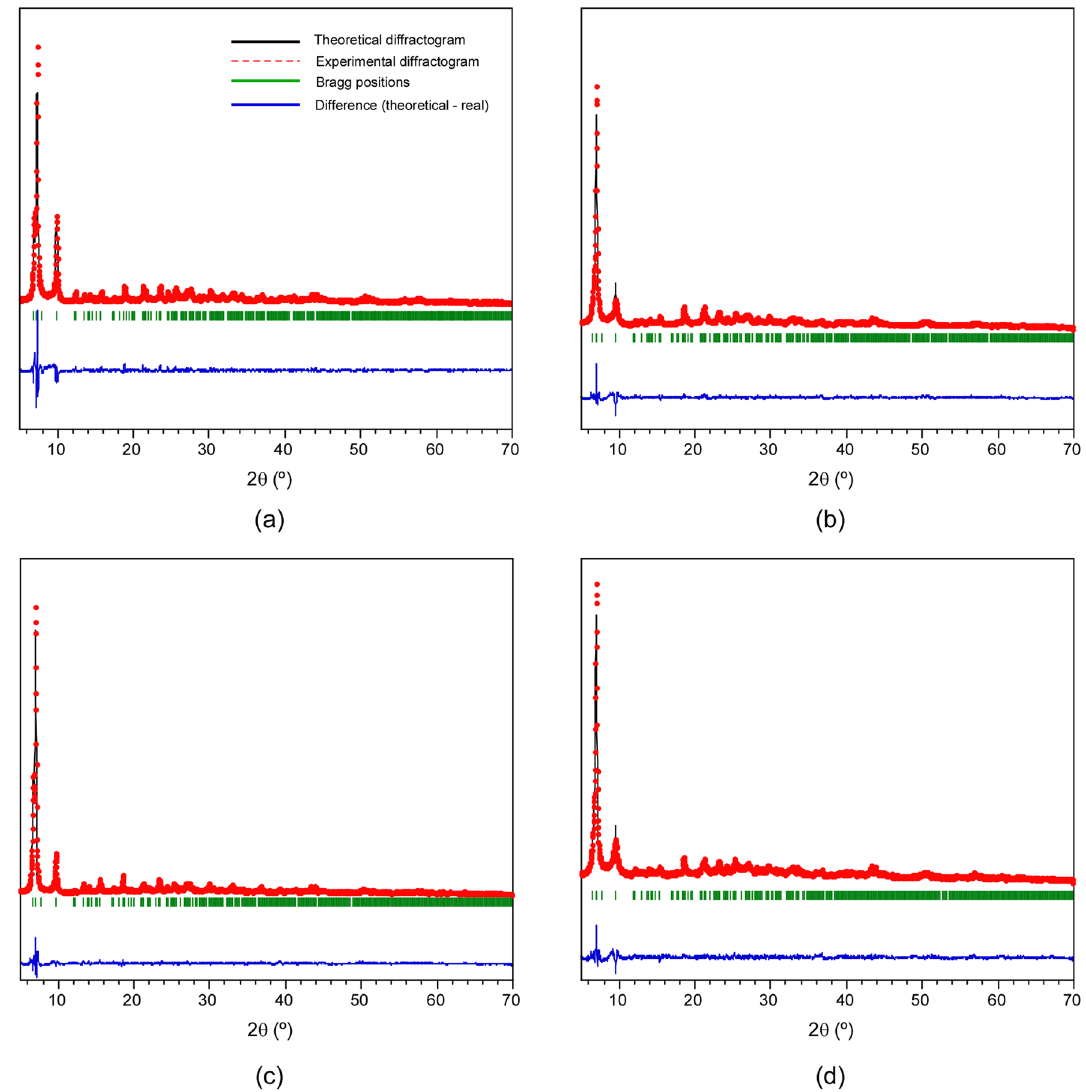
Figure 2. Pattern-matching analysis for ( a ) EHU-30, ( b ) EHU-30-NH 2 , ( c ) Cu@EHU-30 and ( d ) Cu@EHU-